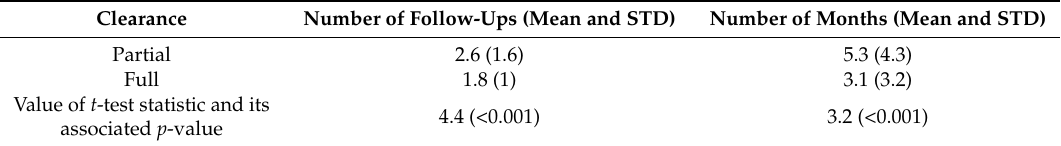
Table 4. Mean number of follow-ups and duration of the treatments (with the corresponding standard deviation) for clearance, with the associated value of the t -test statistics.